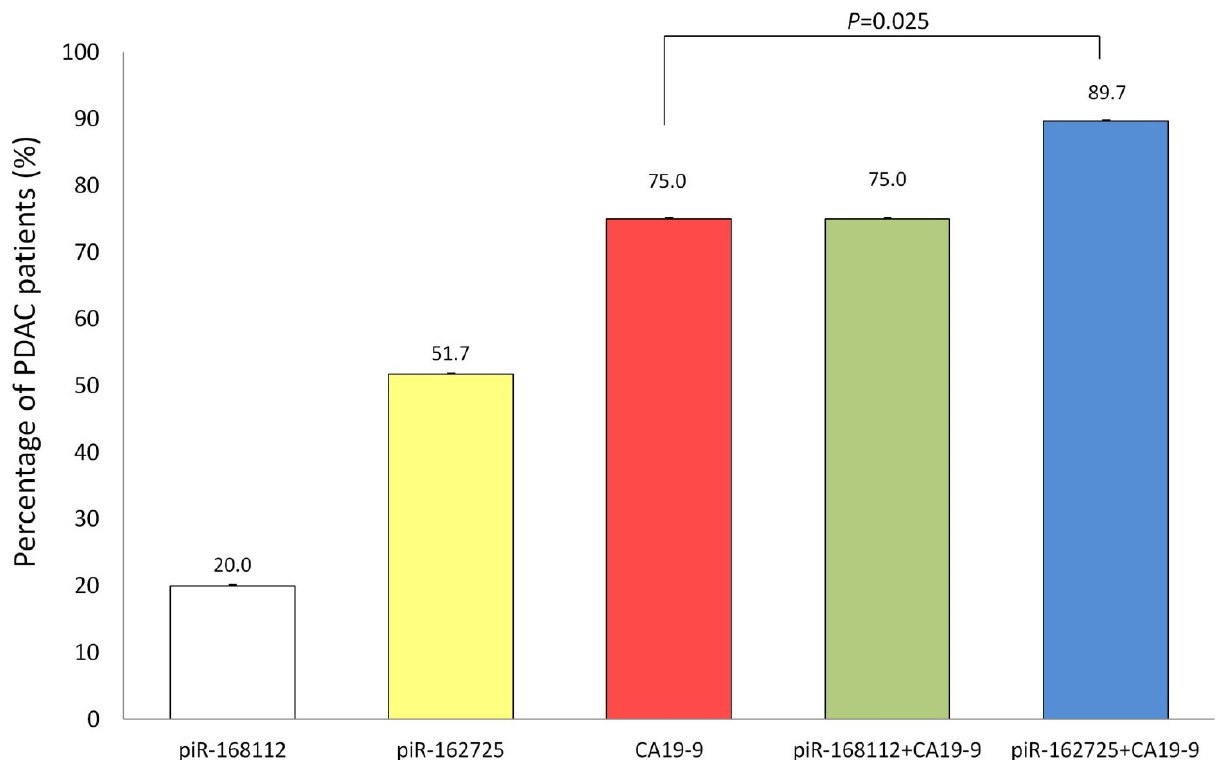
Figure 4. Expression of piR-162725 in human plasma samples enhances the diagnostic potential of CA19-9. The bar graph represents the percentage of PDAC patients identified by any factor individually ( piR-168112 (white), piR-162725 (yellow) , or CA19-9 (red)) or in combination with CA19-9 ( piR168112 +CA19-9 (green) or piR162725 +CA19-9 (blue)). p -value < 0.05 was considered statistically significant.